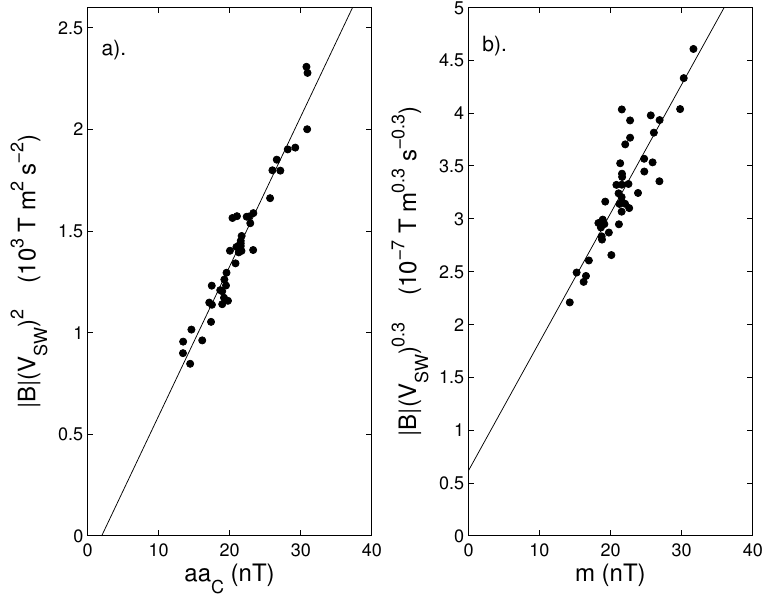
and (right) Figure 15: Scatter plots and best fit regressions of annual means of (left) 𝑎𝑎 𝐶 against 𝐵𝑉 2 SW 𝑚 against 𝐵𝑉 0 . 3 . The best-fit regression lines are derived using the Bayesian least-squares regression fit SW is 𝑟 𝑎𝑎𝑐 = 0 . 97 and procedure described by Rouillard et al. (2007). The correlation for 𝑎𝑎 𝐶 with 𝐵𝑉 2 SW using the autoregressive AR-1 red noise model this correlation is found to be significant at greater than the 10 − 5 level. The correlation of 𝑚 with 𝐵𝑉 0 . 3 is 𝑟 𝑚 = 0 . 89 with significance exceeding the 5 × 10 − 5 level. SW Image reproduced by permission from Lockwood et al. (2009d), copyright by